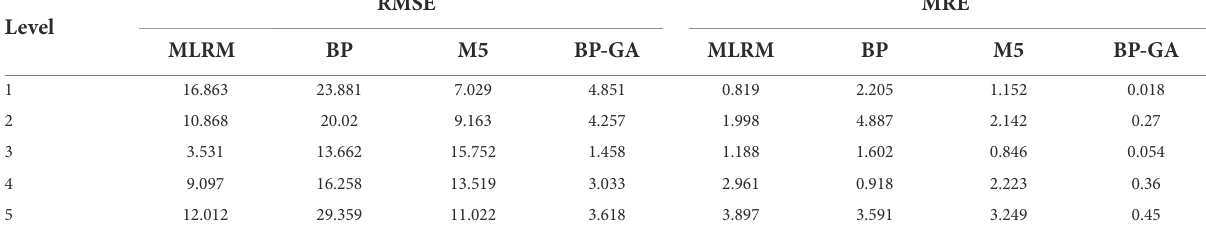
TABLE 3 Comparison of estimation errors of different pollution states.